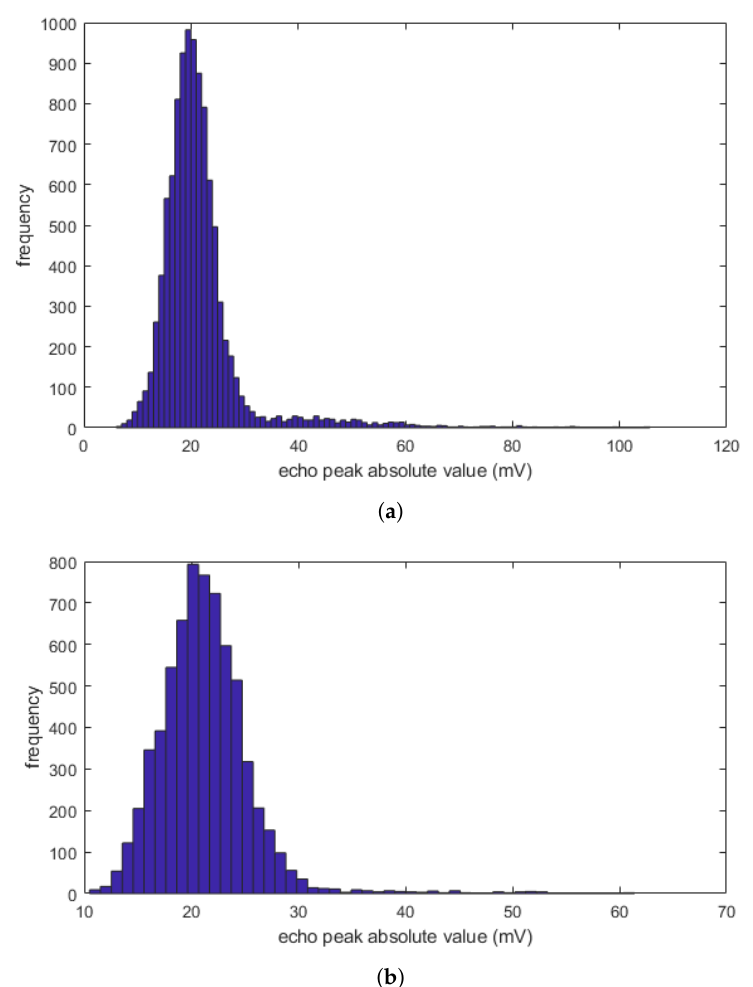
Figure 11. Histogram of the absolute peak values in Zone 3 for ( a ) all A-scans, and ( b ) A-scans with no